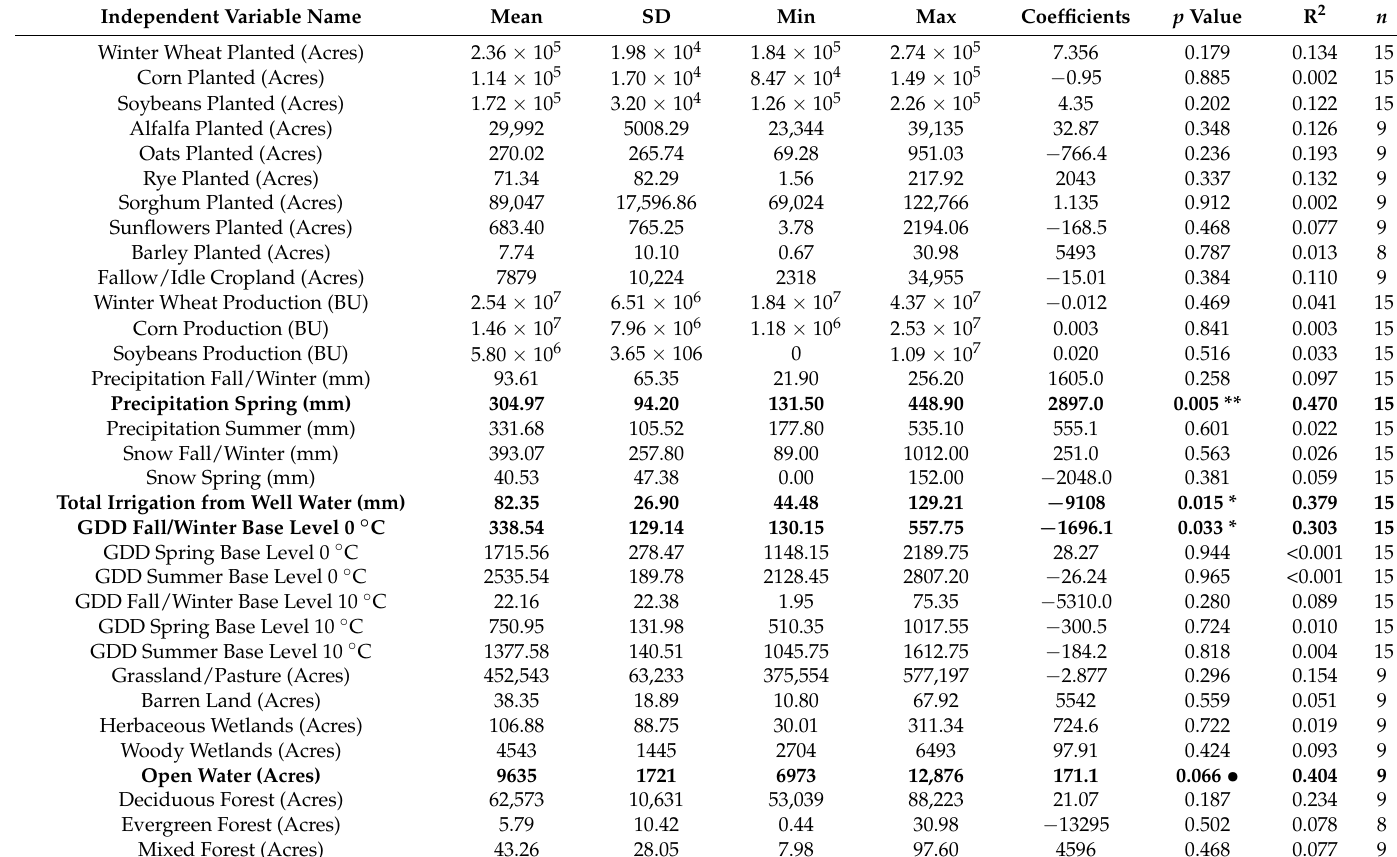
Table A1. The linear regression analysis between various variables and annual nitrate flux ( n = 15). Rows with bold text represent a variable having significant correlation with nitrate flux. Significance levels are denoted by; p < 0.001 shown as *** p < 0.01 shown as ** p < 0.05 shown as * p < 0.1 shown as •